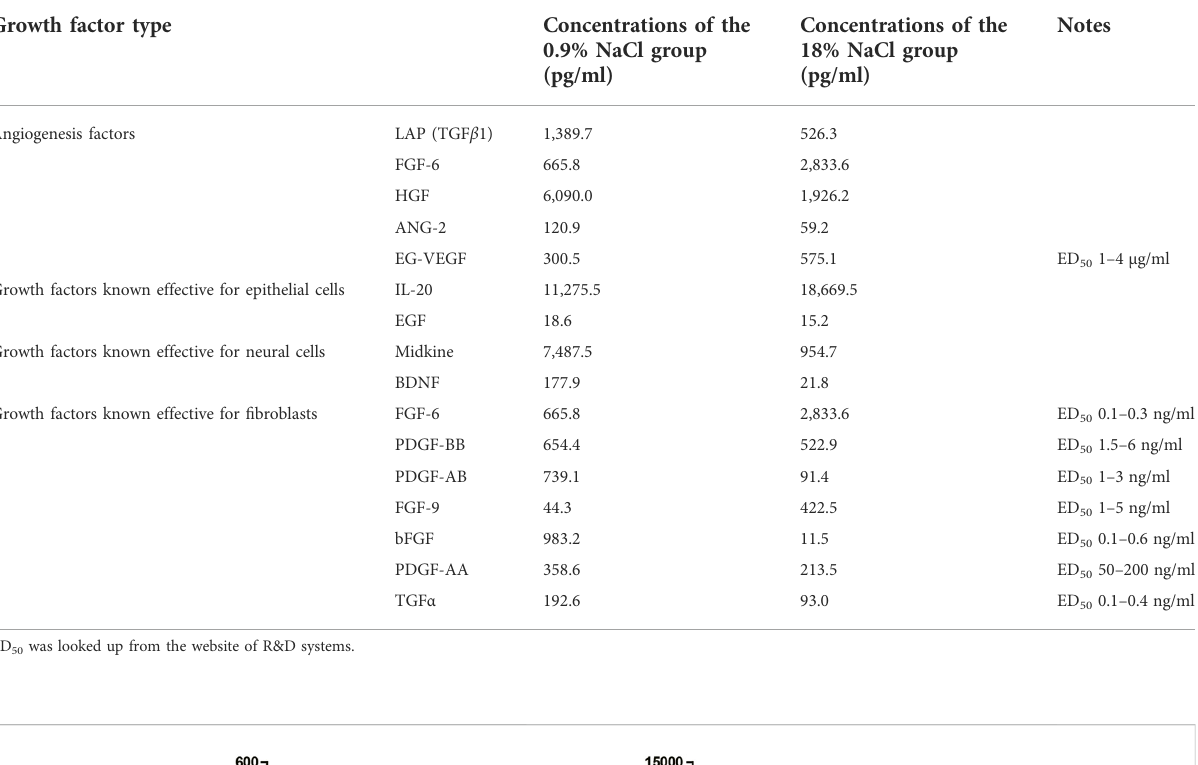
TABLE 1 Multicytokine-array screening results of the amnion/chorion complex derived from normal saline or hypertonic saline washing.